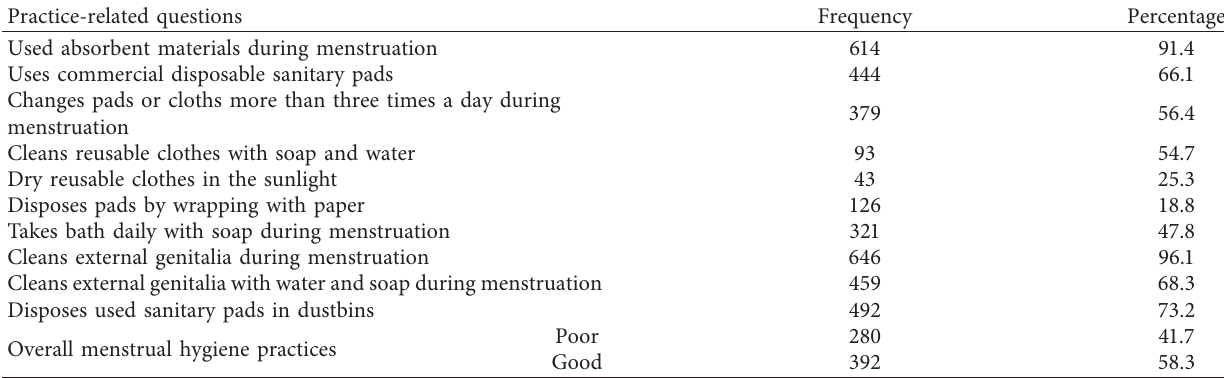
Table 3: Menstrual hygiene management practices of secondary school girls in East Hararghe Zone, Ethiopia, 2017 ( n �